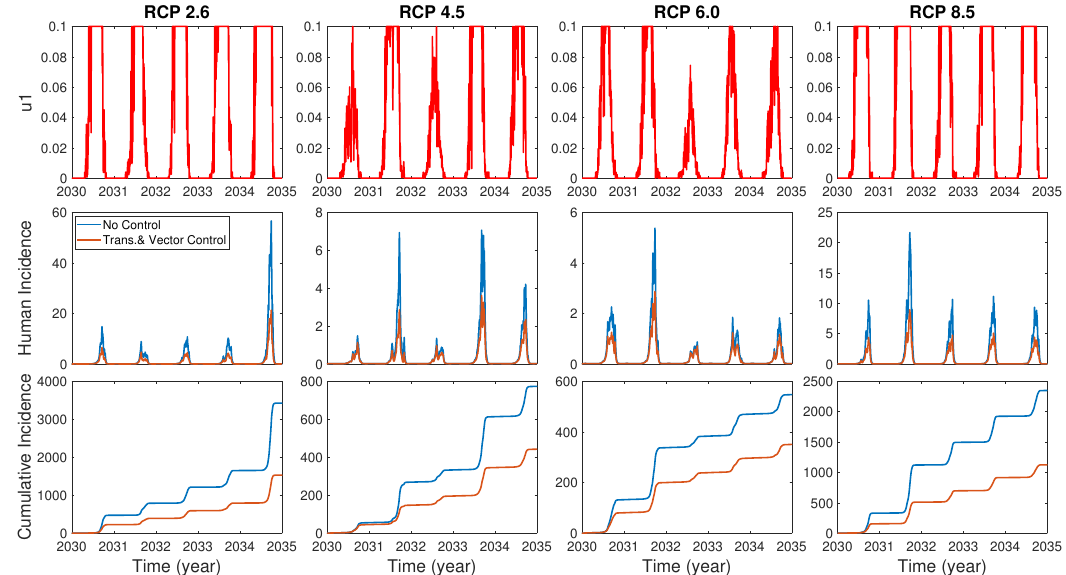
Figure 7. The effect of control of transmissible rates β hv , β vh on the incidences and the optimal control function u 1 .